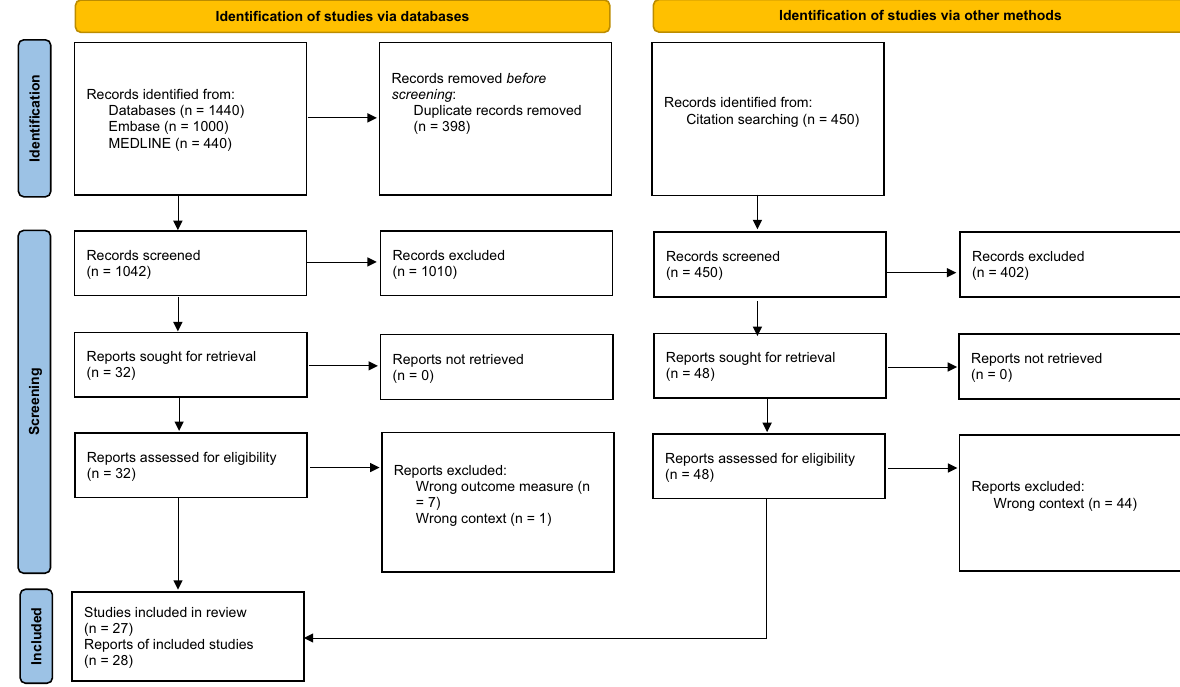
Figure 1. PRISMA flow